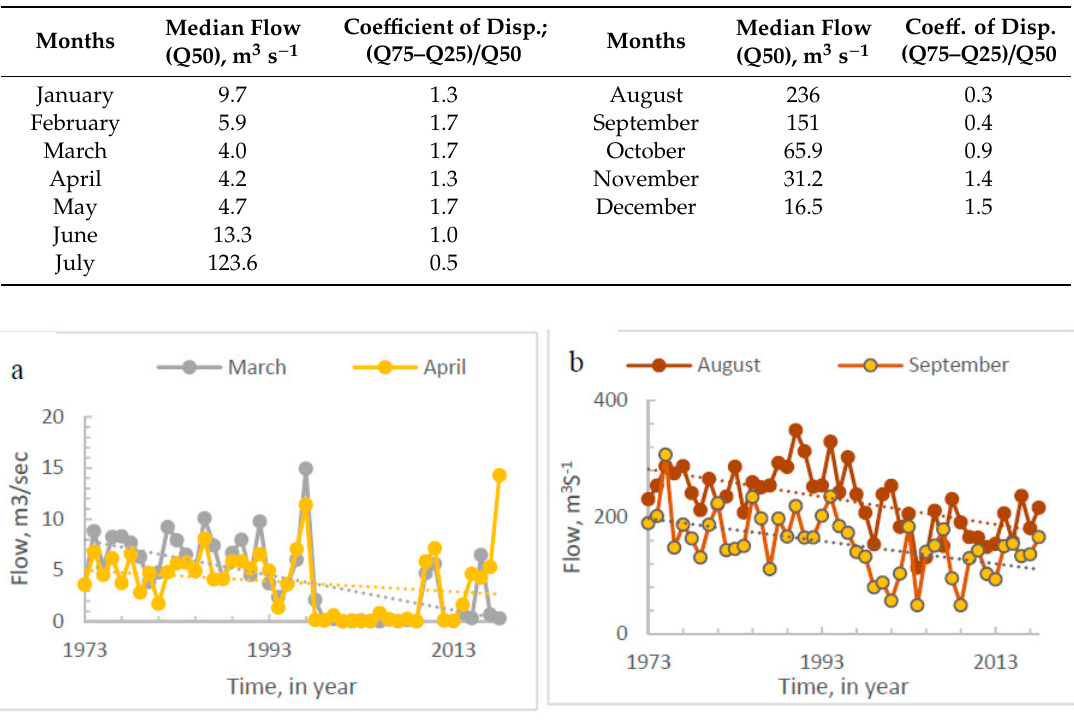
Figure 6. Monthly flow of Gumara 1973–2018 in ( a ) dry season (March and April) and ( b ) wet season (August and September). Both the dry and wet season monthly flows have a decreasing trend.